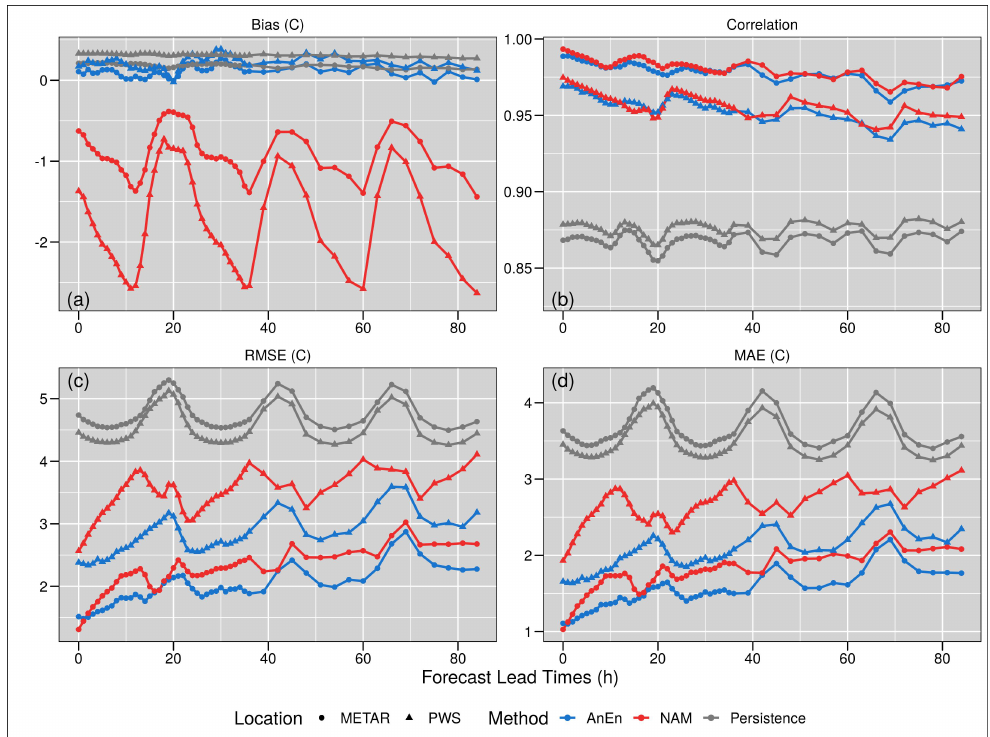
Figure 9. Verification measurements—The figure shows the verification measurements used to verify the performance of the AnEn prediction of the four stations and the other PWSs (blue lines) in comparison to the Pers (dark grey lines) and to the downscaled NAM-NMM forecasts model, in terms of bias ( a ), correlation ( b ), RMSE ( c ) and Mean Absolute Error (MAE) ( d